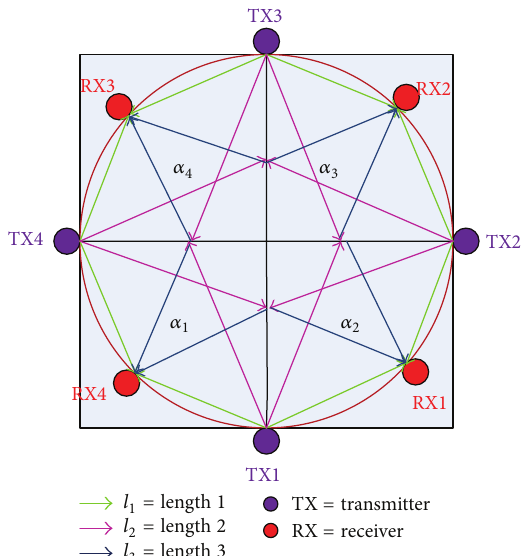
Figure 6: Model of four-sensor pair with four